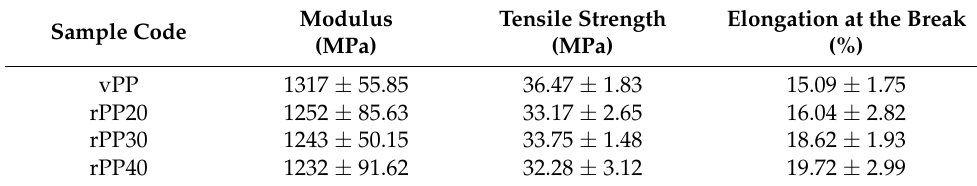
Figure 5. Effect of varying rPP contents on the mechanical properties of PP blends. Table 1. Mechanical properties of the vPP specimens blended with rPP at various